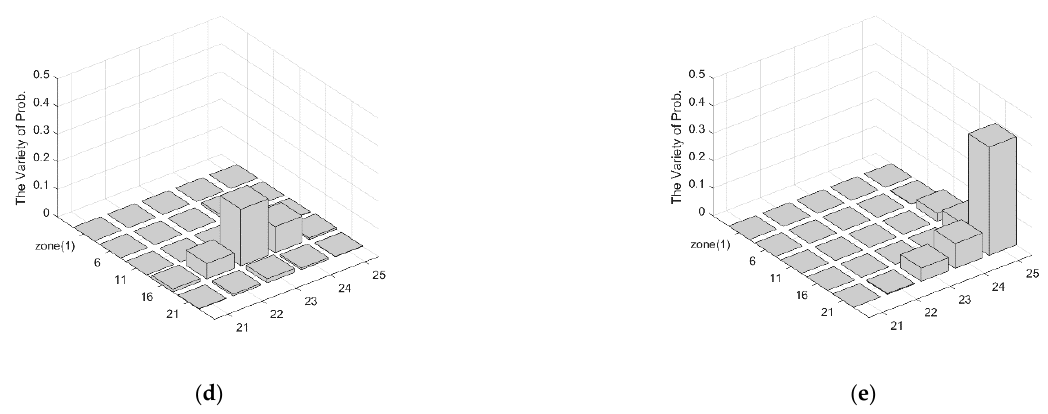
Sensors 2021, 21 , x Figure 7. The distribution of ∆(cid:1842)(cid:1870)(cid:1867)(cid:1854) (cid:3038)(cid:2879)(cid:2869)~(cid:3038)(cid:3053) of Input 01 about Route 01*: ( a ) 0~1 st sampling interval, ( b ) 1~2 nd sampling Figure 7. The distribution of ∆ Prob z of Input 01 about Route 01*: ( a ) 0 ∼ 1st sampling interval, ( b ) 1 ∼ 2nd sampling k − 1 ∼ k interval, ( c ) 2~3 rd sampling interval, ( d ) 3~4 th sampling interval, and ( e ) 4~5 th sampling interval. interval, ( c ) 2 ∼ 3rd sampling interval, ( d ) 3 ∼ 4th sampling interval, and ( e ) 4 ∼ 5th sampling interval.